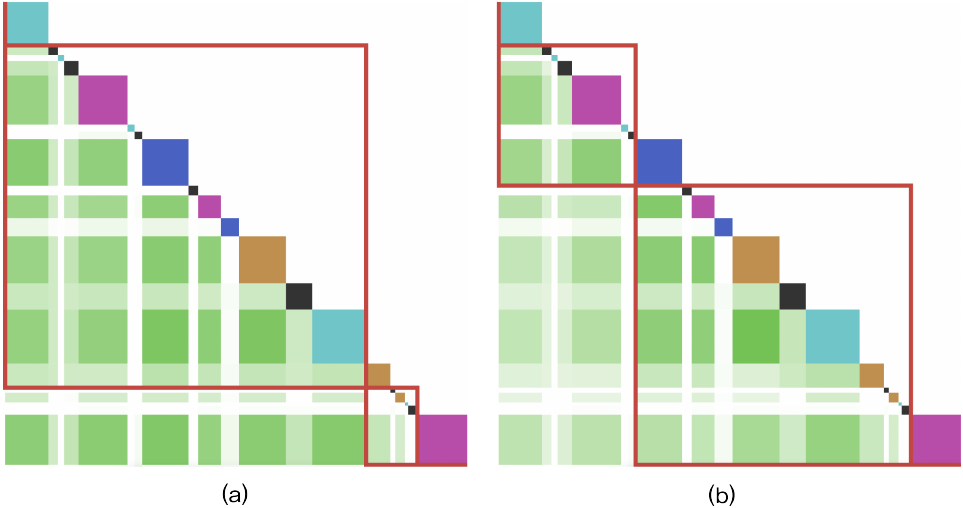
Figure 11. Before ( a ) and after ( b ) other-continuity is applied to conceptual similarities. By applying the weight of the metric that quantifies the other-continuity, the transcript is segmented based on the corresponding conceptual similarities of